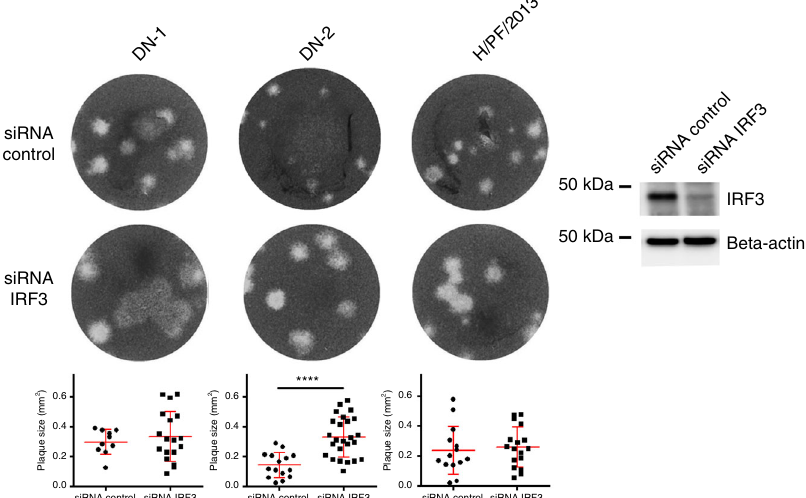
Fig. 3 Immune-restriction of DN-2 replication confers small-plaque phenotype. Plaque sizes of DN-1, DN-2, and H/PF/2013 after siRNA knockdown of IRF3 in BHK-21 cells. Western blot analysis of cells was performed 48 h after siRNA transfection to determine knockdown ef fi ciency as shown in the cropped blots (representative data of three experiments). Error bars represent s.d. **** p < 0.0001 in unpaired t test